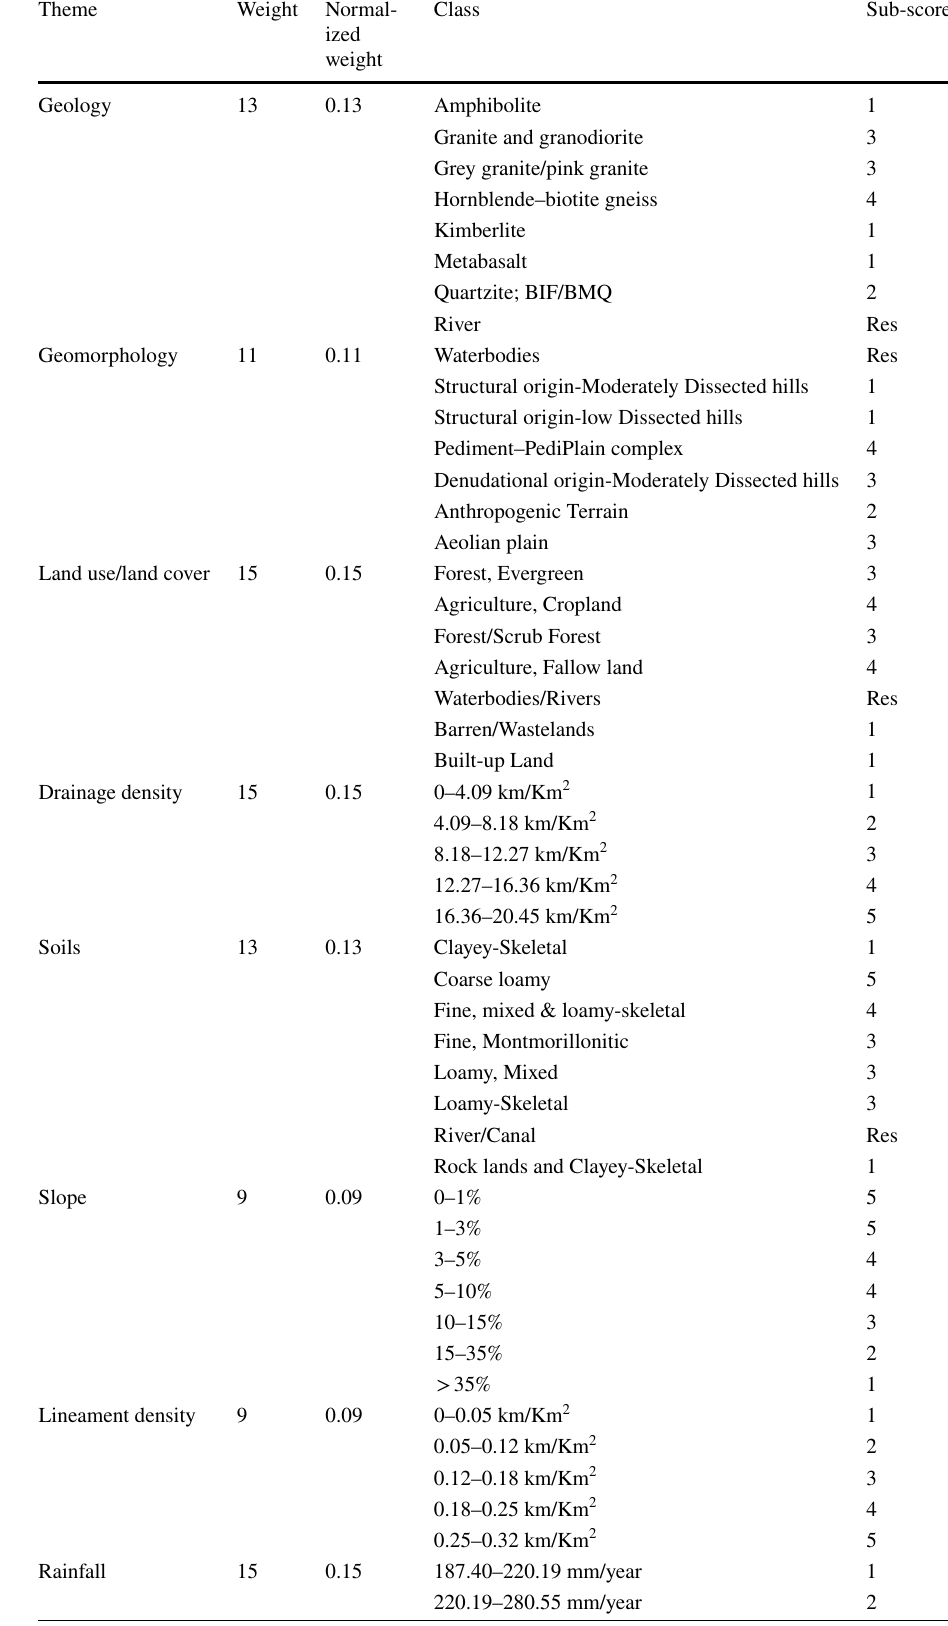
Table 1 Criteria, sub-criteria, and AHP weights for